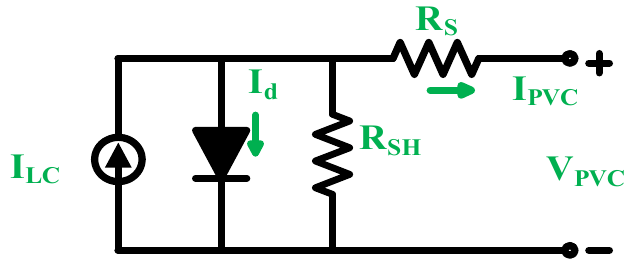
Figure 1. PV cell model.